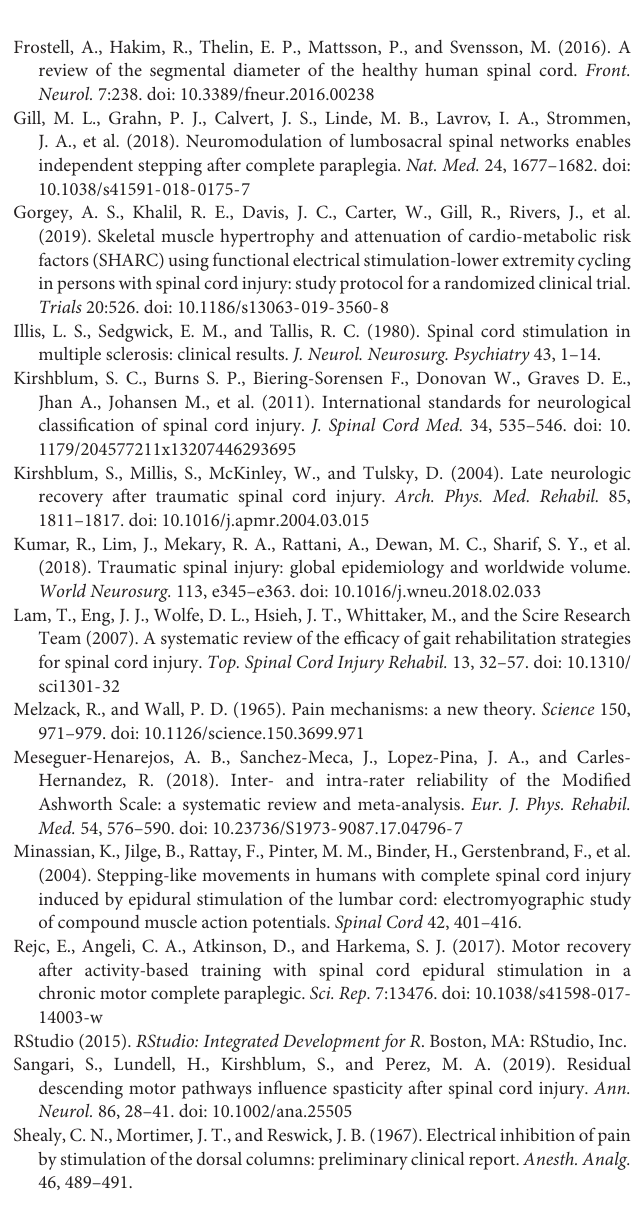
TABLE S1 | Summary of means and standard deviations (SD) for all variables used to assess differences between groups. P -values are obtained from single variable Mann-Whitney U tests. SVM: Spontaneous volitional movement. Non-SVM: No spontaneous volitional movement.